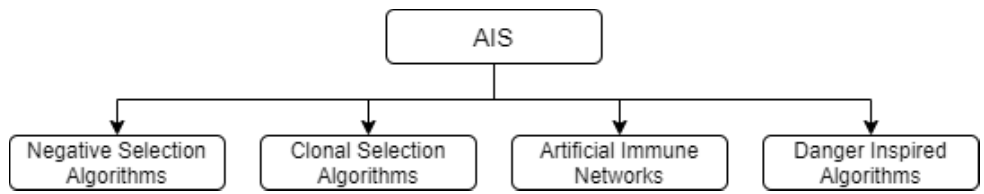
Figure 1. Artificial Immune System (AIS) taxonomy used in this work